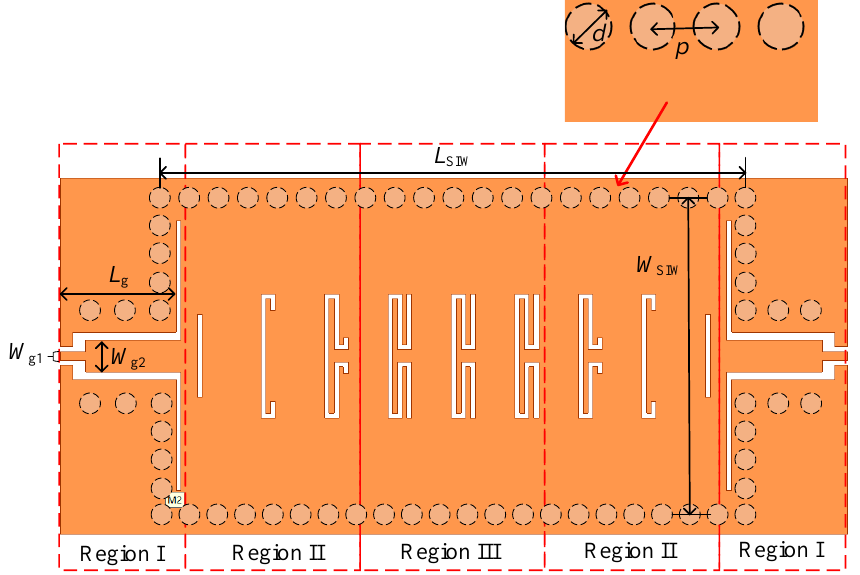
Figure 2. Vertical view of the proposed SIW BPF based on SSPP. The TE101 mode resonant frequency of the SIW cavity is adopted as the low-cutoff frequency, and the dimensions are determined as in [31]: